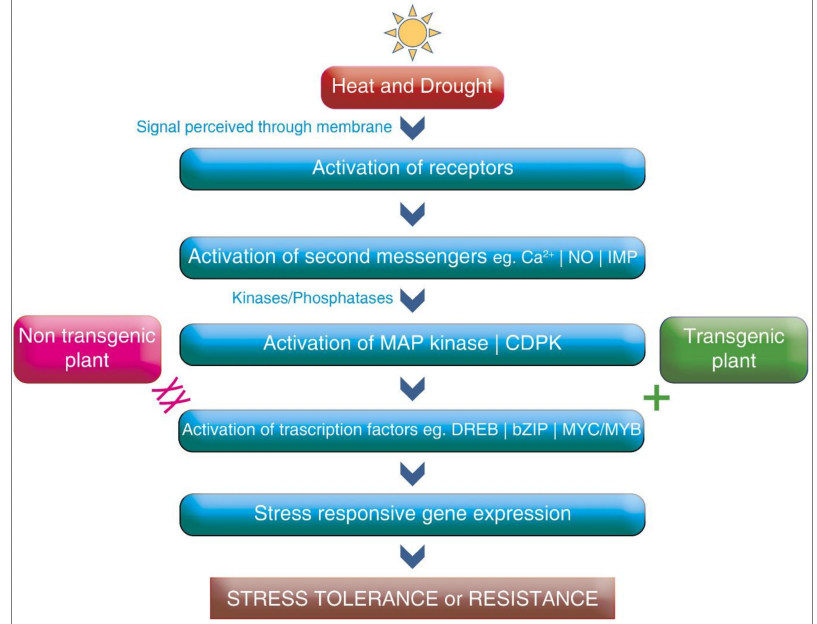
Figure 2. The basic mechanism of the transgenic approach during